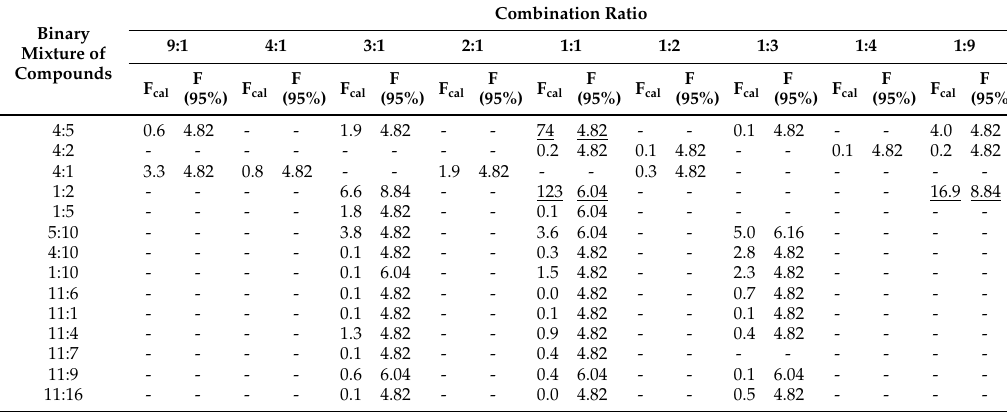
Table 6. Comparison of the additive and experimental regression lines for binary mixtures of compounds with the F-distribution ( α = 0.05) to distinguish two regression lines (if F cal > F there is a significant difference).